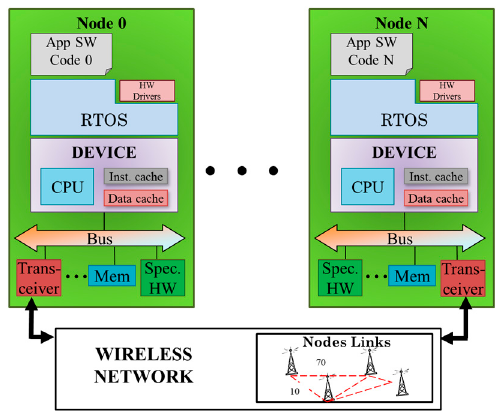
Figure 2. Scheme of Wireless Sensor Network virtual platform without attack model.